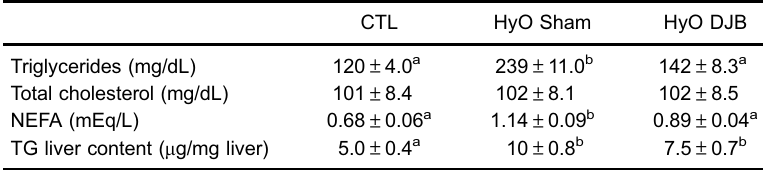
Table 2. Serum lipid parameters and triglycerides (TG) liver content in control (CTL), hypothalamic obese (HyO) Sham and HyO with duodenal-jejunal bypass (DJB) rats.